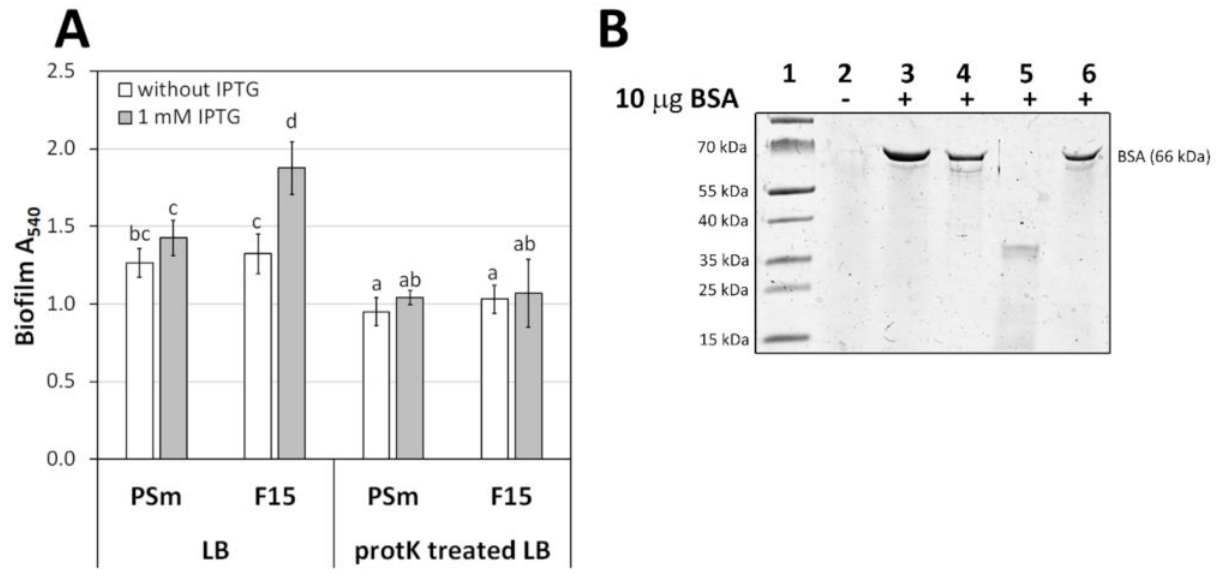
Figure 3. The effect of LB proteinaceous component for P. putida biofilm. ( A ) The biofilm of P. putida strains PSm and F15 in LB medium and the proteinase K-treated LB medium. Biofilm of P. putida strains. The arithmetical averages are shown. Brackets show the 95% confidence intervals, and the homogenous groups are shown above columns by the lower-case letters. Identical letters denote non-significant differences ( p ≥ 0.05) between averages of biofilm. ( B ) SDS-gel electrophoresis LB medium supplemented with BSA. Lane 1, protein marker; lane 2, 10 µ L of LB medium; lane 3, 10 µ g of BSA; lane 4, LB medium + BSA without proteinase K treatment; lane 5, LB medium + BSA after 2 h proteinase K treatment; lane 6, proteinase K-treated LB medium amended with 10 µ g of BSA after incubation in 121 ◦ C and incubated at 37 ◦ C for 2